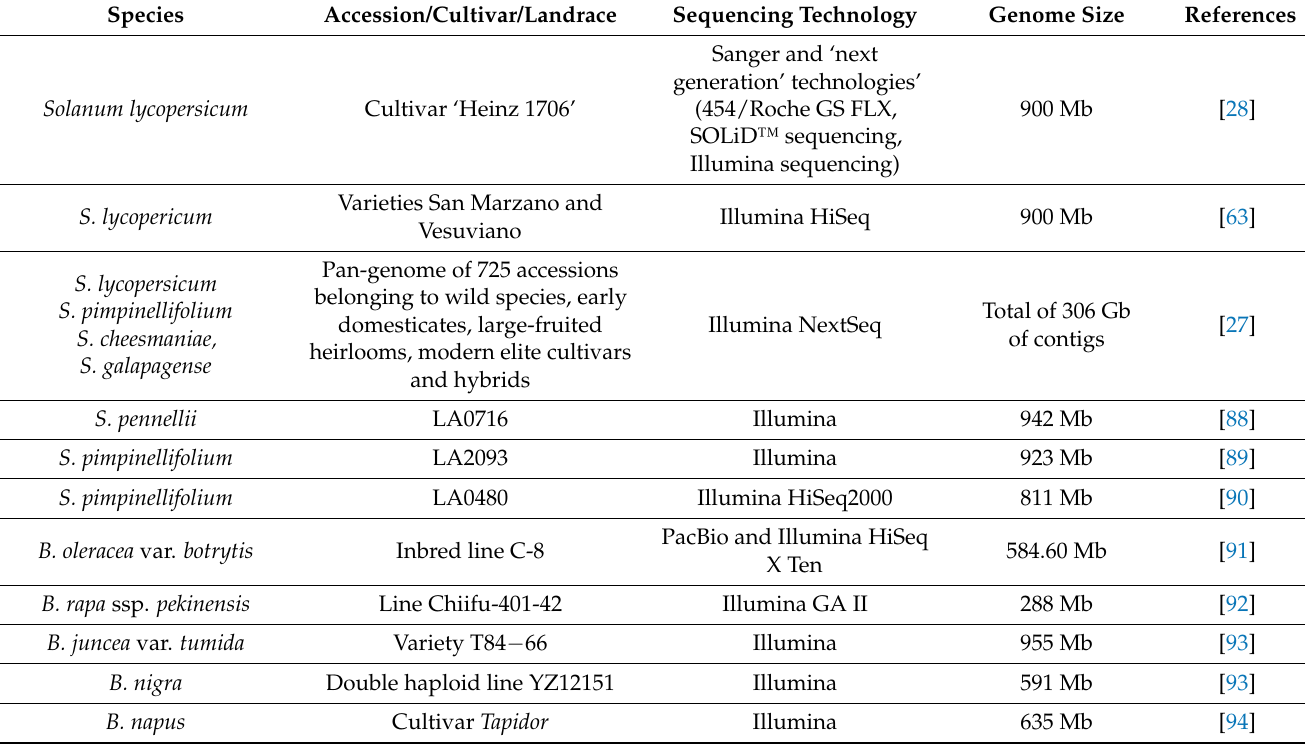
Table 1. Information about some genome sequences available in tomato, cauliflower, and related species.